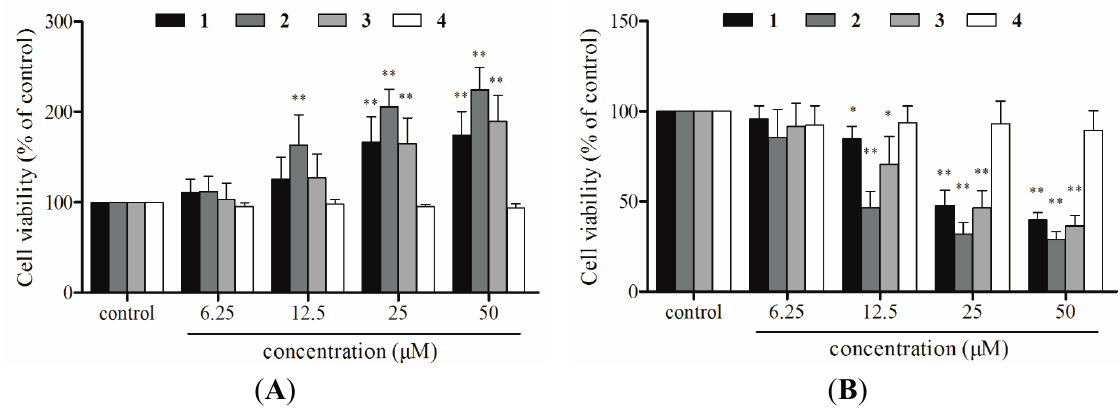
Figure 2. Effects of compounds 1 – 4 on cell viability. EA.hy926 cells were treated